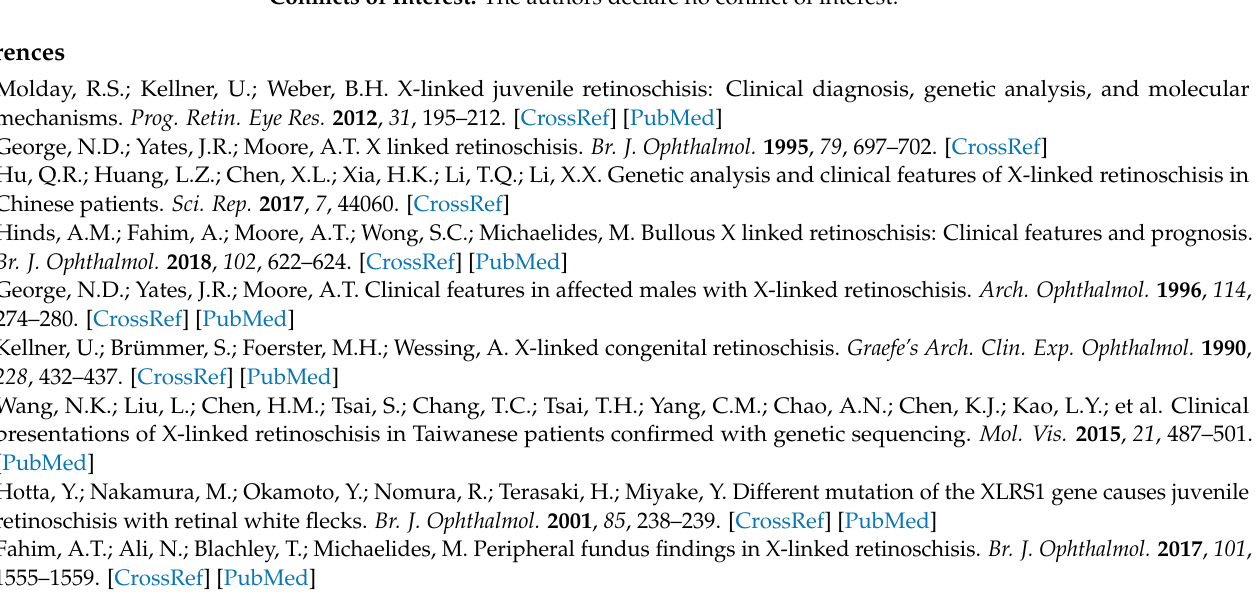
segregation of the identified RS1 mutations, Figure S2: Clinical findings in individual F1-III:1 aged 39 years, Figure S3: Clinical findings in individual F5-II:1 aged 15 years, Figure S4: Clinical findings Table S1: Summary of clinical data in 21 male individuals with X linked